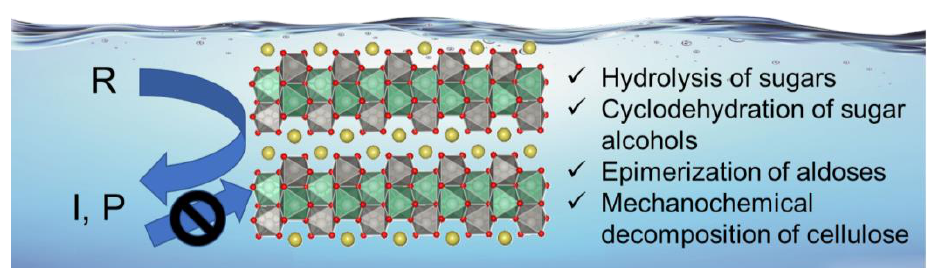
Figure 2. Sugar transformation in water using layered HNbMoO 6 solid acid.